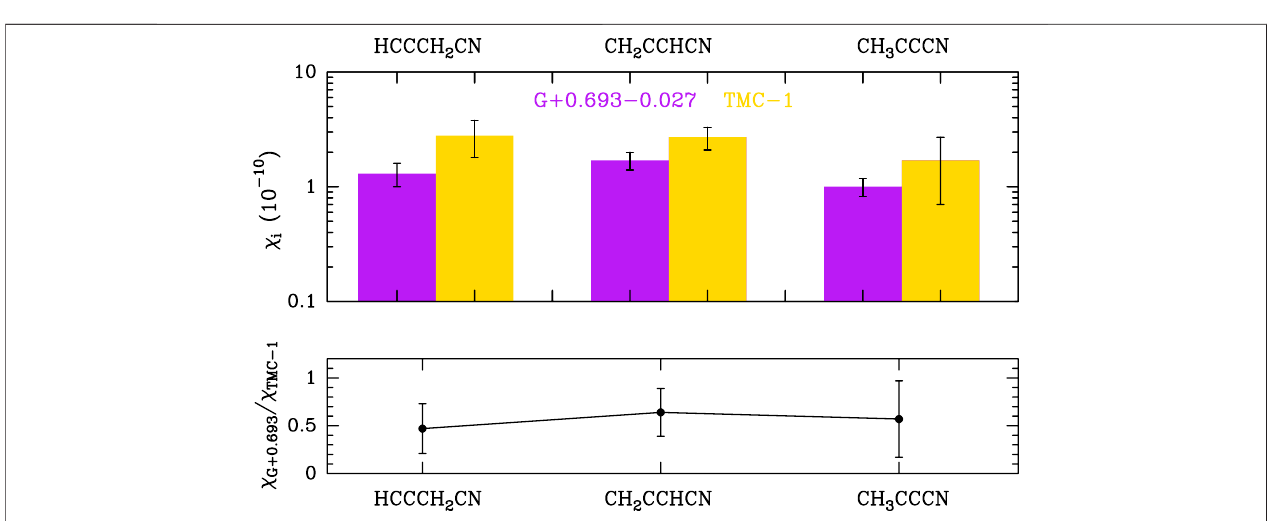
FIGURE9| Upper panel:AbundanceswithrespecttoH 2 oftheC 3 H 4 Nisomersdetected towardsG+0.693(purple;thiswork)andTMC-1(yellow,Marcelino etal., 2021).ToderivetheuncertaintiesofthemolecularabundanceswehaveconsideredtheuncertaintiesofthemolecularcolumndensitiesoftheC 3 H 4 Nisomersreportedin this work ( Table 4 ) and in Marcelino et al. 2021, and we assumed an uncertainty for the N (H 2 ) column density of 15%. Lower panel: Molecular ratios between the abundances of the C 3 H 4 N isomers in G+0.693 and TMC-1.